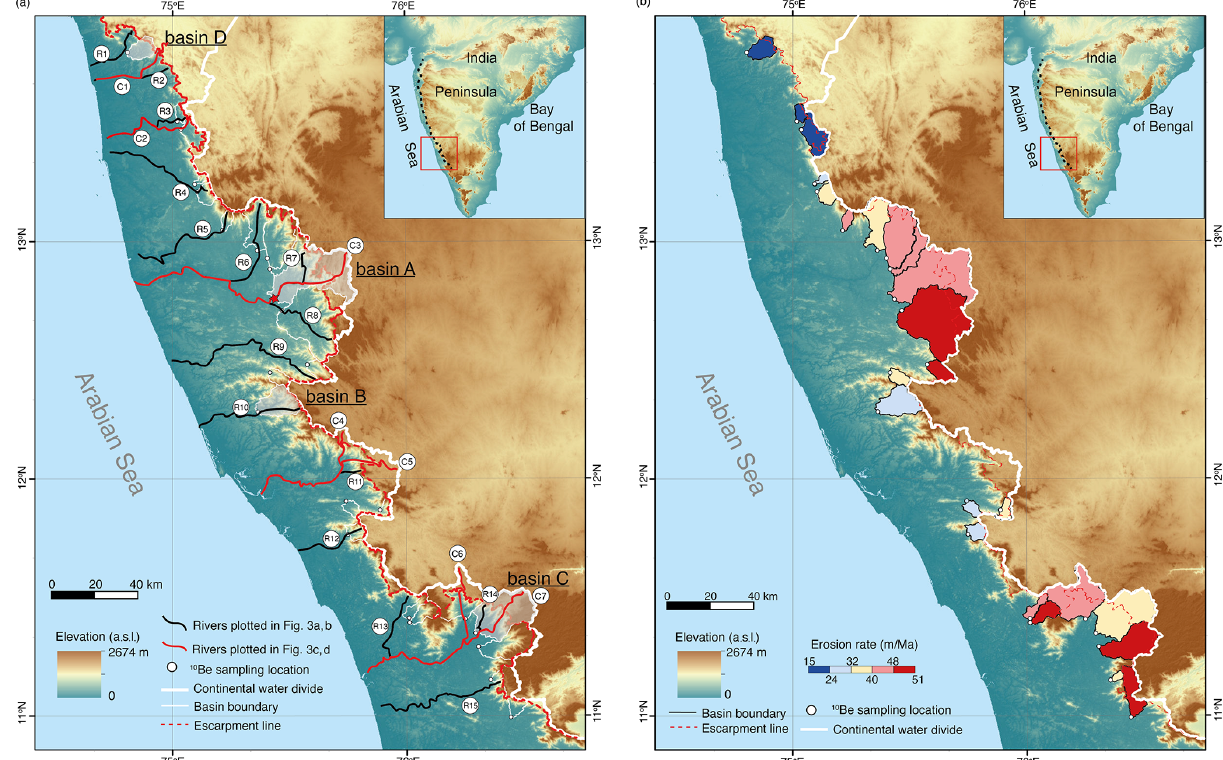
Figure 2. (a) Shuttle Radar Topography Mission (SRTM) 90m digital elevation model (DEM) (Jarvis et al., 2008) showing the topographic overview of the southern Western Ghats escarpment (location is indicated in the inset figure), escarpment-draining rivers (in solid black and red lines) and the continental water divide (solid white line). The dashed red line denotes the Western Ghats escarpment, and we take the southern limit of the Deccan Traps as the boundary between the northern and southern segments. The 10 Be sample locations of Mandal et al. (2015) are indicated by filled white circles. (b) Cosmogenic 10 Be-derived erosion rates. Erosion rate is recalculated from the published concentrations of Mandal et al. (2015) following the method of Lupker et al. (2012). See Table 1 for the